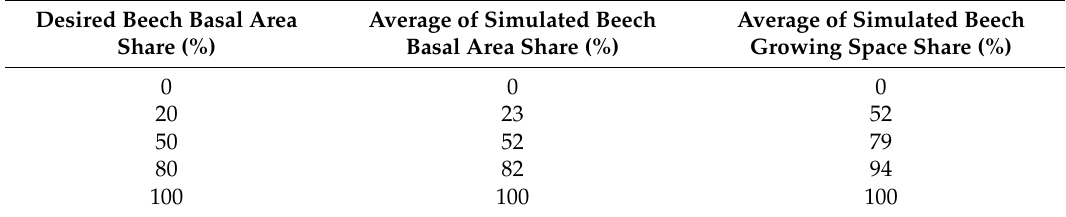
Table 5. Average values over simulation time of 100 years with default desired basal area